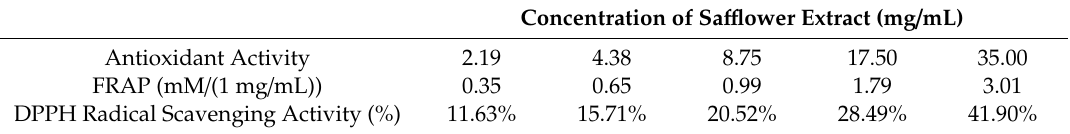
Table 3. The results of antioxidant activities. DPPH: 1,1-diphenyl-2-picrylhydrazyl, FRAP: Ferric reducing antioxidant